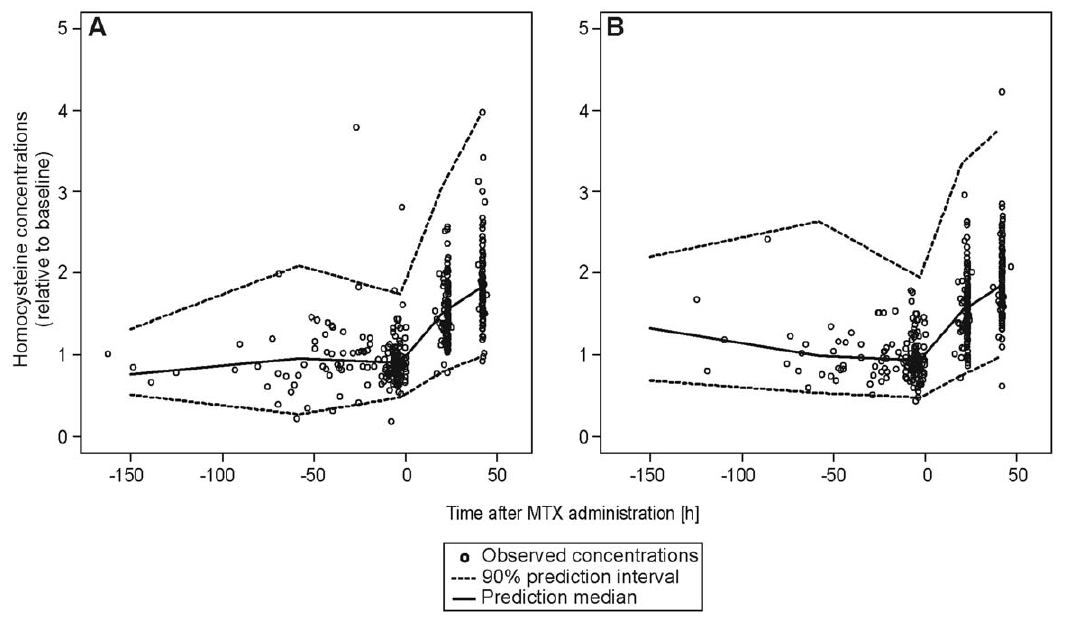
Figure 4. Visual predictive check of the pharmacodynamic model for low-risk (A) and standard/high-risk (B) patients from the evaluation dataset. The black circles represent the measured homocysteine concentrations relative to baseline. The solid line represents the median predicted concentration, the dashed lines represent the 90% prediction interval of 1000 simulations.